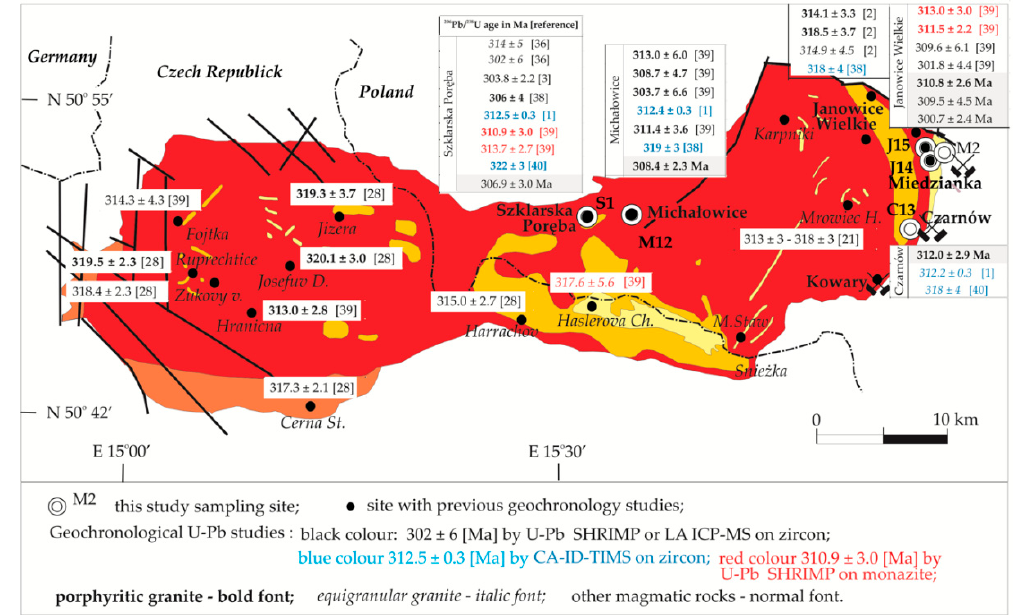
Figure 12. U-Pb and Re-Os isotopic geochronology of igneous rocks and sulfides from the KP and its eastern metamorphic cover.